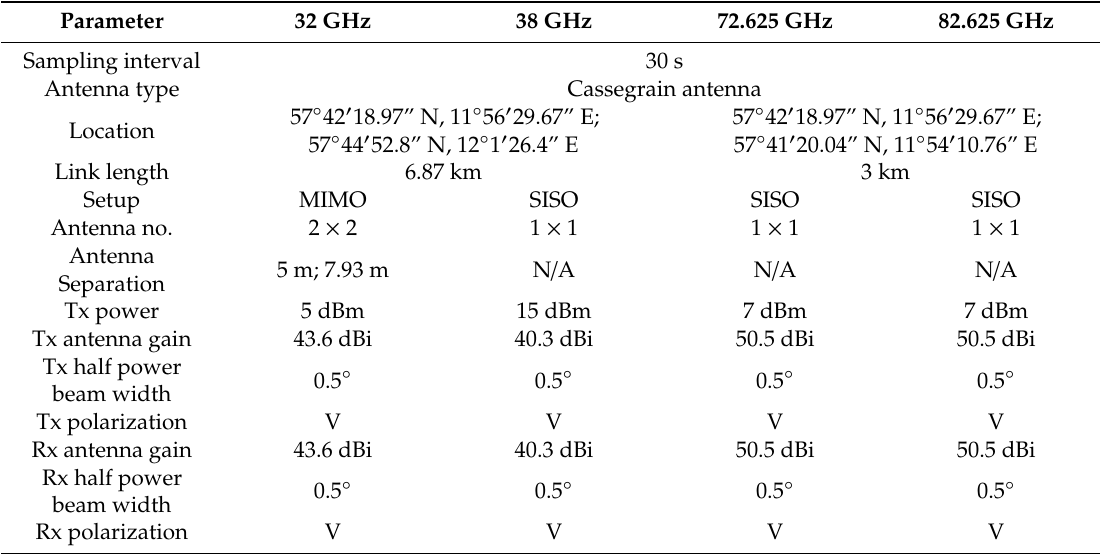
Table 3. Outdoor measurement